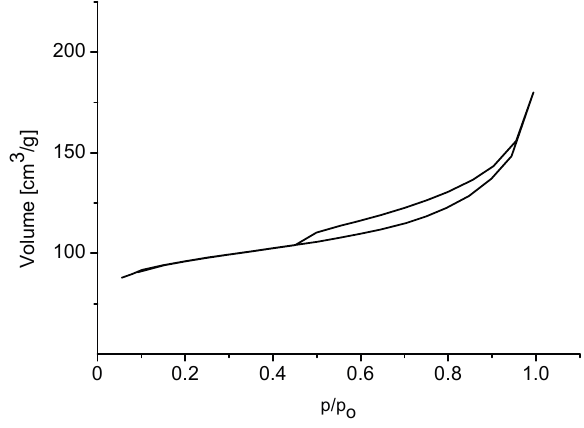
Figure 4. Adsorption/desorption isotherms of nitrogen on the ZSM-12 sample. Table 1. Sorption properties of the ZSM-5, ZSM-12, MCM-22 and Beta type zeolites.